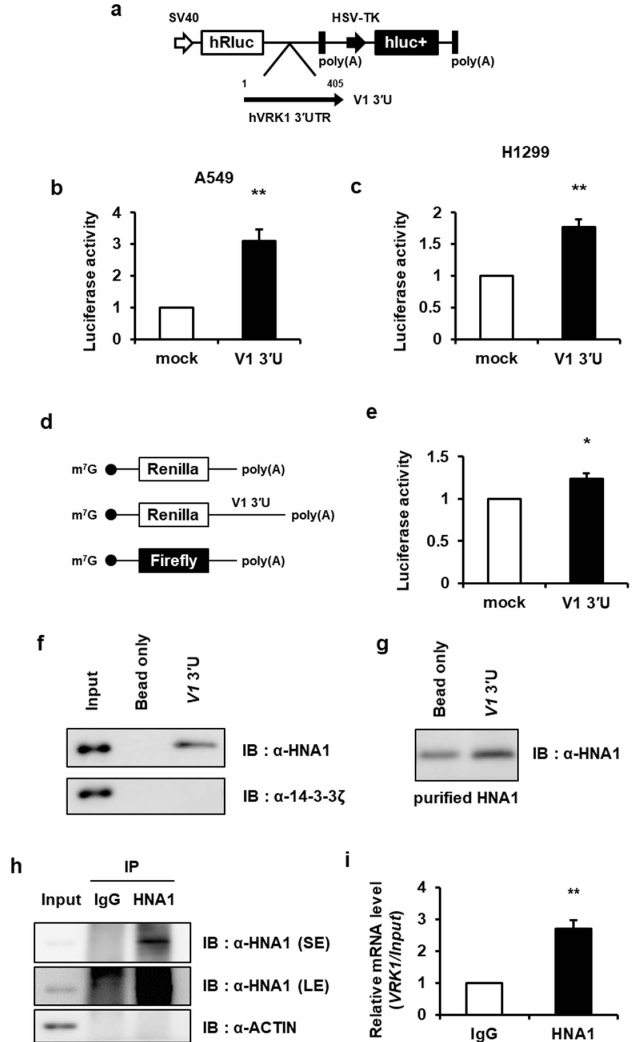
Figure 1. The 3 (cid:48) UTR of VRK1 is involved in translation and HNRNP A1 directly interacts with the 3 (cid:48) UTR of VRK1 mRNA. ( a ) Schematic drawing of reporter gene construct is shown. Reporter construct is composed of the psiCHECK2-backbone plasmid that encodes the Renilla luciferase gene followed by the human 3 (cid:48) UTR of VRK1 (V1 3 (cid:48) U). ( b , c ) Levels of reporter activities are measured by analysis of VRK1 3 (cid:48) UTR (V1 3 (cid:48) U) luciferase reporter. Luciferase activity is shown as the ratio of hRluc to hluc+ and the luciferase activity of mock was set as 1. Bars represent means ± s.e.m. (unpaired two-tailed Student’s t -test, n = 4; ** p < 0.01). ( d ) Schematic representation of the mRNAs measured in this experiment are shown. Firefly mRNA reporters were also used for normalization. ( e ) Mock and VRK1 3 (cid:48) U mRNAs were synthesized in vitro by T7 RNA polymerase and were transfected into A549 cells using Lipofectamine 2000. After a 12-h incubation, luciferase assays were performed (unpaired two-tailed Student’s t -test, n = 4; n.s., not significant; * p < 0.05). ( f ) The in vitro-transcribed VRK1 3 (cid:48) UTR construct was labelled with biotin-UTP and was incubated with cell lysates of HEK293A cells. Biotin-UTP labelled VRK1 3 (cid:48) UTR was pulled down with streptavidin bead. Then, streptavidin affinity purified samples were separated by SDS-PAGE and were subjected to immunoblot analysis with the indicated antibodies. ( g ) To prove the direct interaction of HNRNP A1 and VRK1 3 (cid:48) UTR, biotin-conjugated VRK1 3 (cid:48) UTR was prepared by in vitro transcription and was incubated with non-tagged purified HNRNP A1. Then, the biotin-conjugated VRK1 3 (cid:48) UTR was pulled down using streptavidin, which were later subjected to immunoblot analysis with the indicated antibodies. ( h ) Western blot analysis for HNRNP A1 and ACTIN in HEK293A cell lysate after IP with mouse anti-HNRNP A1 or mouse IgG shows enrichment for HNRNP A1 and depletion of other proteins, as indicated by absence of ACTIN in IP fractions. ( i ) Endogenous HNRNP A1 binds to endogenous VRK1 mRNA. Lysates from HEK293A cells were used for RNA immunoprecipitation (RNA-IP) analysis using IgG and anti-HNRNP A1 antibodies. RNA abundance in IP samples was determined by qRT-PCR. Bars represent means ± s.e.m. (unpaired two-tailed Student’s t -test, n = 3; ** p <